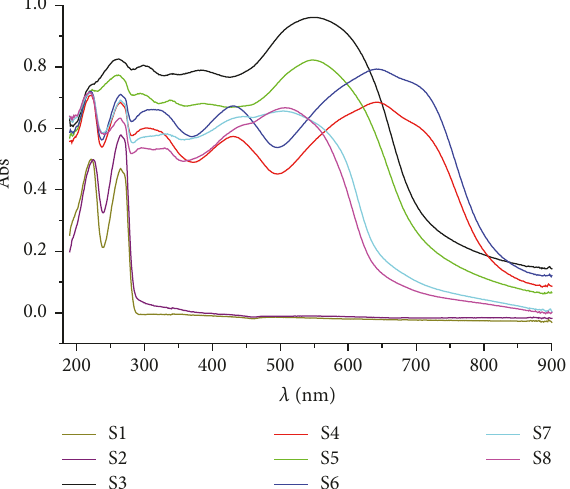
Figure 3: UV-vis spectra for compounds S1–S8.